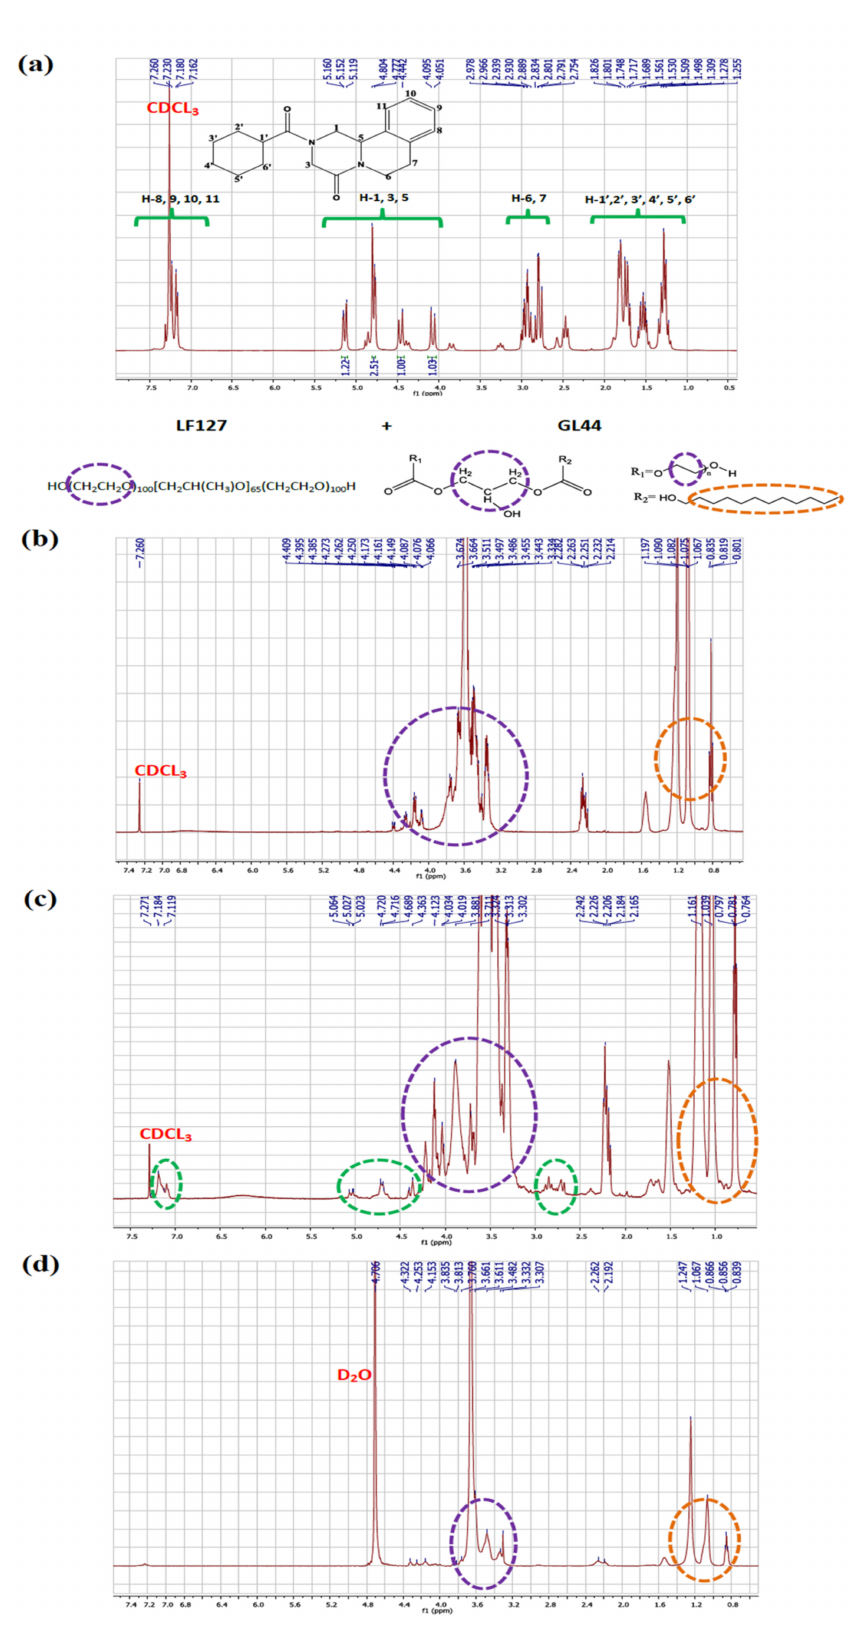
Figure 4. 1 H NMR spectra of ( a ) PRZ in CDCl 3 , ( b ) blank PMMs, ( c ) PRZ-PMMs in CDCl 3 and ( d ) PRZ-PMMs in D 2 O with peaks allocated according to the corresponding molecular